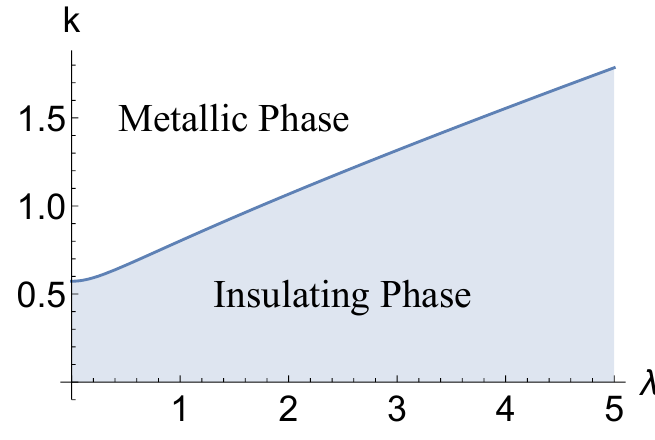
Figure 1 . MIT phase diagram at T = 0.001